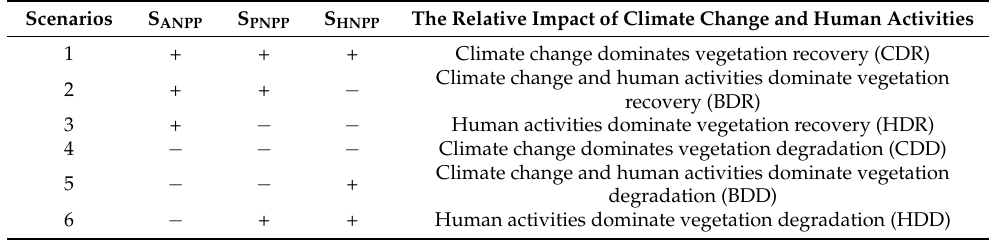
Table 1. Assessment scenarios of the impact of climate change and human activity on